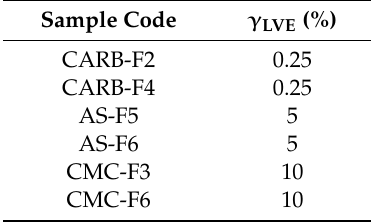
Table 2. The limits of the linear viscoelastic range ( γ LVE ) for the tested gel